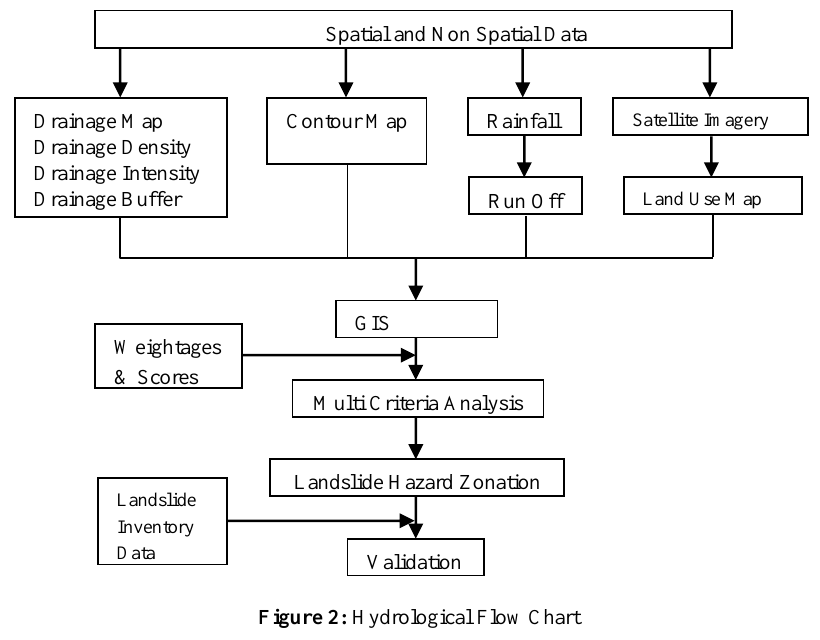
Figure 2: Hydrological Flow